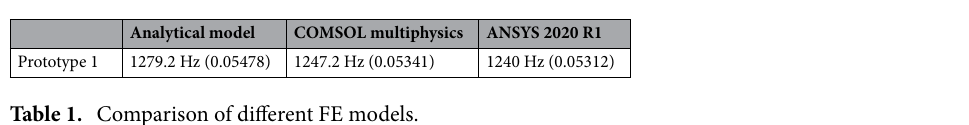
Table 1. The parameter m incorporates the mass of cylinders and cubes for Prototype 1 or cylinders and spheres for Prototype 2 that works as rigid body while parameter k represents the longitudinal stiffness of supporting frame κγ k SB 31 . Here κ and γ are associated with the stiffness of two sets of beams and the summation structure with k = of two orthogonal beam stiffnesses, respectively, that are connected with the rigid cylindrical masses via small 0.5 and γ 2 31 . Furthermore, as shown in Fig. 1b, cubes/spheres. For the present symmetric frame assembly κ = = 24 EI / L 3 L / 3 w b / 2 the stiffness of single beam is k SB for a single beam with the effective length L el el where = = − 1 w b w 3 I L el is effective length of beam. The analytical and numerical results h is second moment of area and 12 = comparison for Prototype 1 is presented in Table 1 and there exists an error of about 2.5–3% between numerical and analytical solutions for the opening bounding edge of the first BG. For Prototype 2 the BG opening bound- ing edge obtained from COMSOL Multiphysics and ANSYS 2020 R1 are 929.24 Hz (0.03981) and 939.86 Hz (0.04026), respectively. The vibration modes obtained from COMSOL Multiphysics and ANSYS Workbench is shown in Fig. 1c to double check the accuracy. An excellent agreement can be observed in term of deformation mechanism and displacement field distribution. Further details can be found in the supplementary materials.